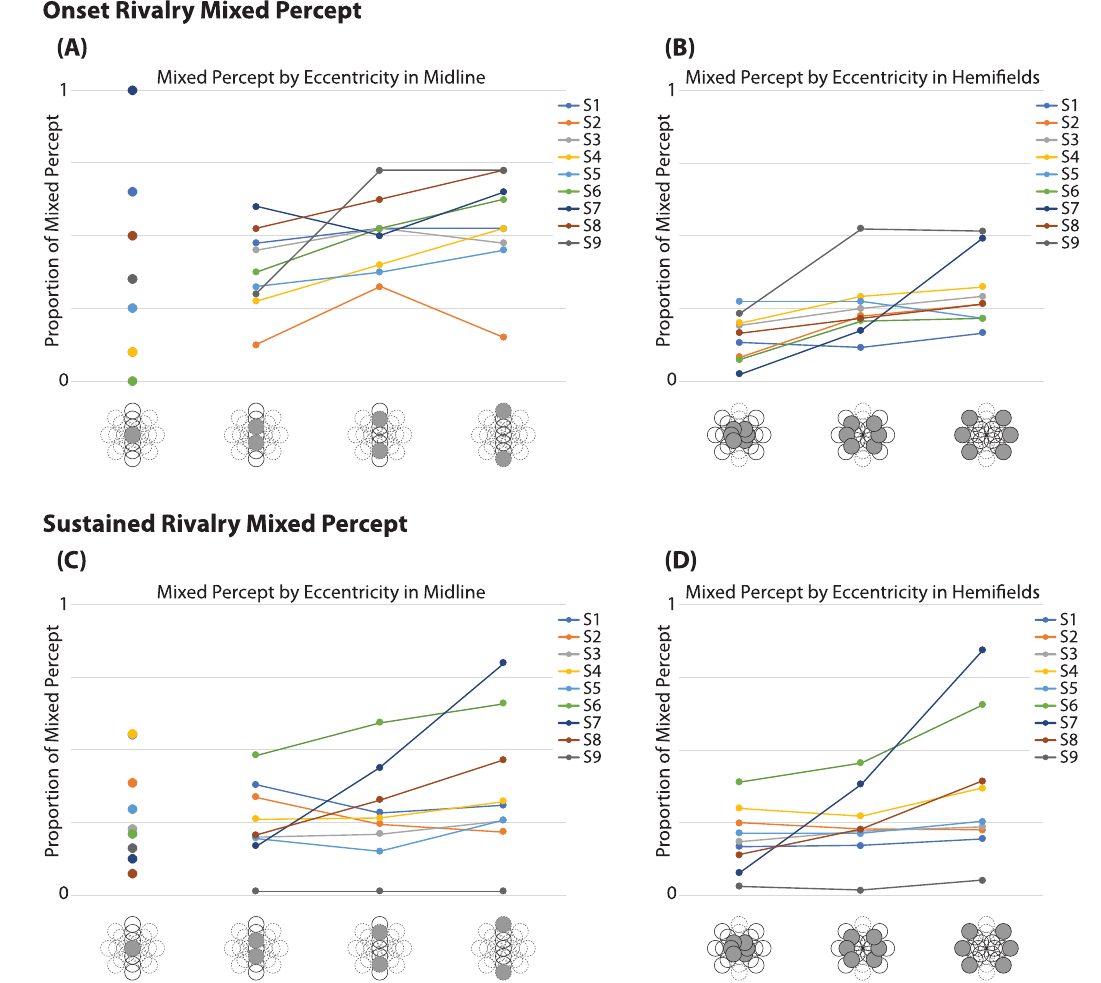
Figure 4. Mixed Report Along Eccentricities: The average proportion of mixed percept during onset at fixation and the three subsequent eccentricities along the midline ( A ) and in the hemifields ( B ). At onset, the proportion of mixed percept is highly variable between observers at fixation, but more closely clustered in the hemifields. During sustained rivalry, the proportions appear less spread out at fixation (shown with midline eccentricities ( C )) and more spread out in the hemifields ( D ) than at rivalry onset.